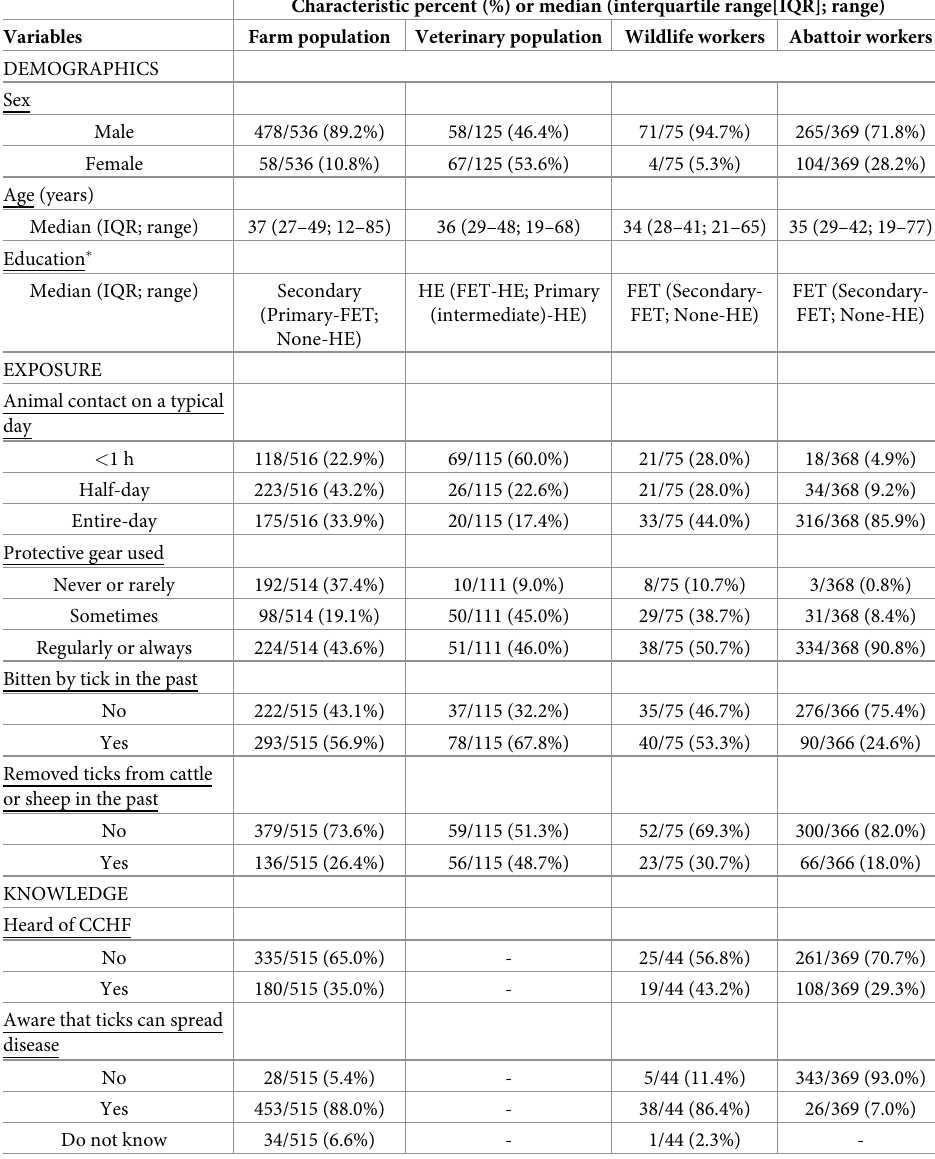
Table 1. Demographic, socio-economic and exposure characteristics of four occupational groups, central South Africa, 2017–2018 (All survey participants, N=1127). Characteristic percent (%) or median (interquartile range[IQR]; range) Variables Farm population Veterinary population Wildlife workers Abattoir